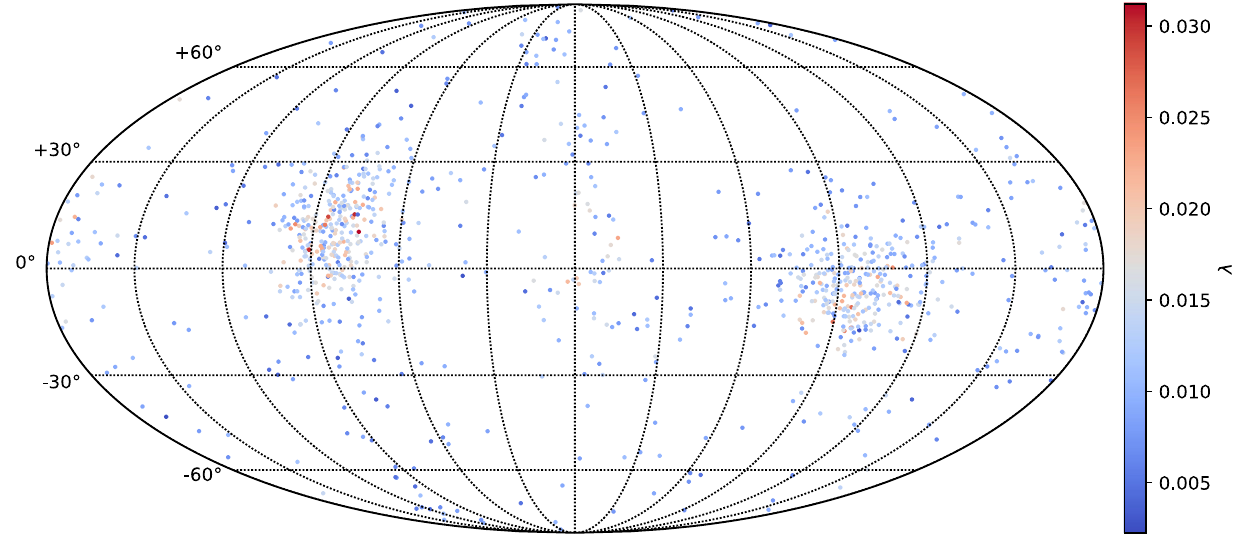
Fig. 15 Distribution of eigenvectors with maximum eigenvalues of fitted quadrupole matrices, with eigenvalues represented in different colors